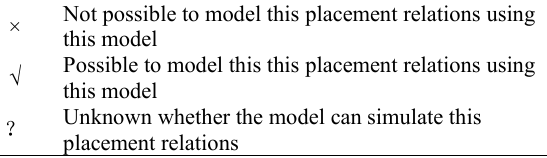
Table 2. Rating scheme of simulation models on placement